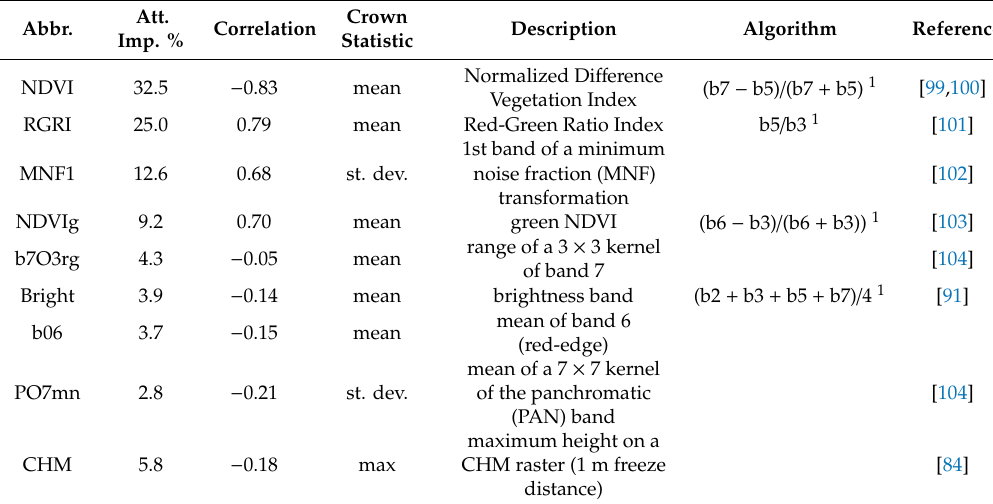
Table 4. Selection of WV2 attributes and their importance for a description of the seven-level reference scheme. The maximum crown height value was added for crown stratification. The attribute importance (imp.) for the RF regression was calculated as the average impurity decrease and converted to the percentage. Abbr. Algorithm Reference